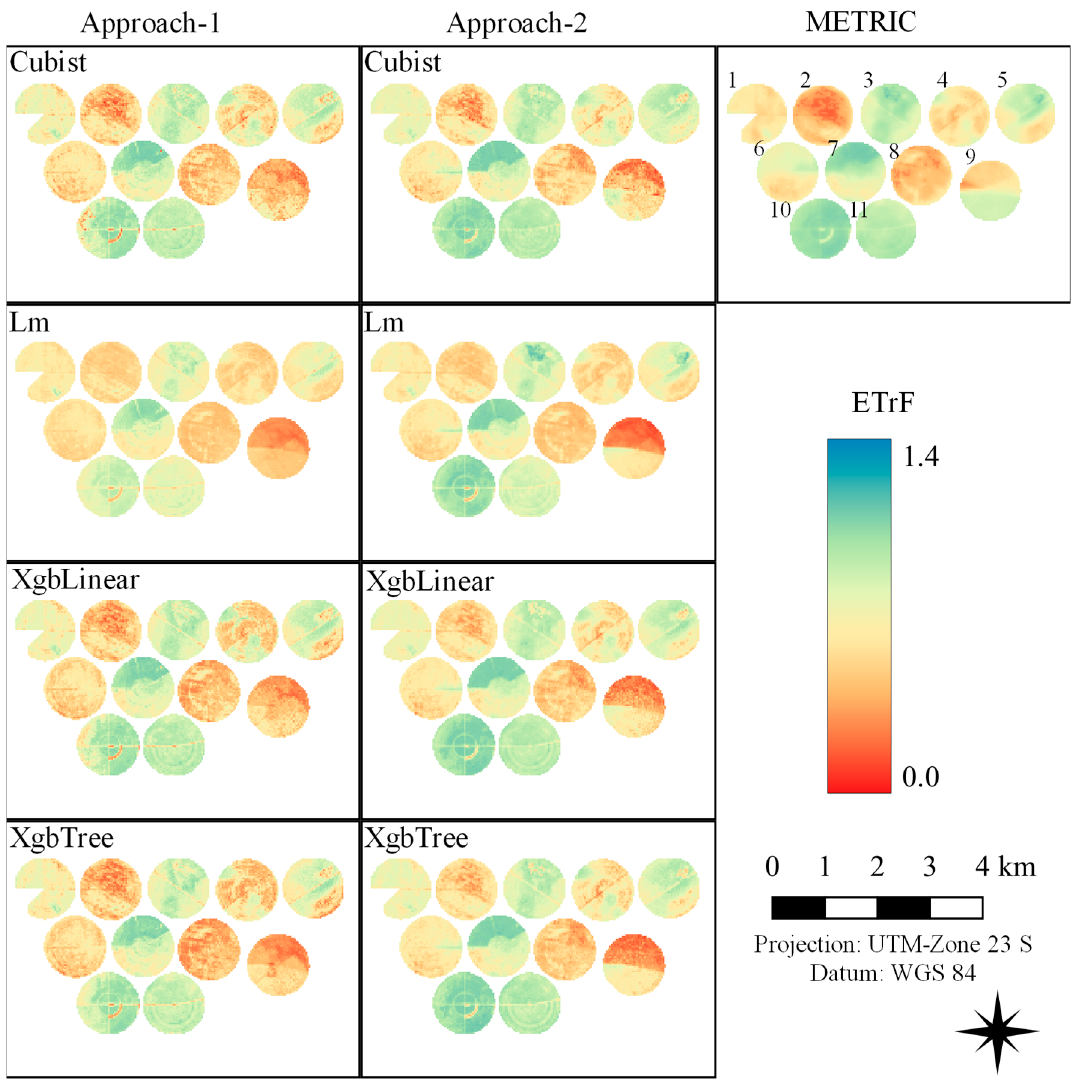
Figure 9. Spatial variability of ET r F for approaches 1, 2, and Metric for 02/12/2020.